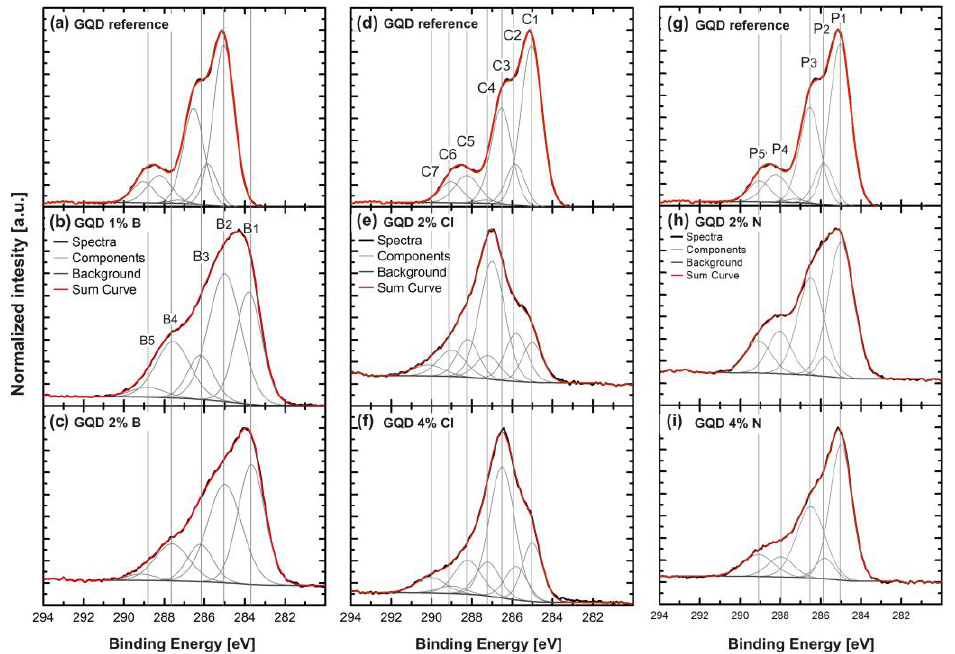
Figure 4. C1s core level spectra of ( a ) the GQD reference sample; ( b ) 1% B-GQDs; ( c ) 2% B-GQDs. The components (B1–B5) and the background are indicated; ( d ) the GQD reference sample; ( e ) 2% Cl-